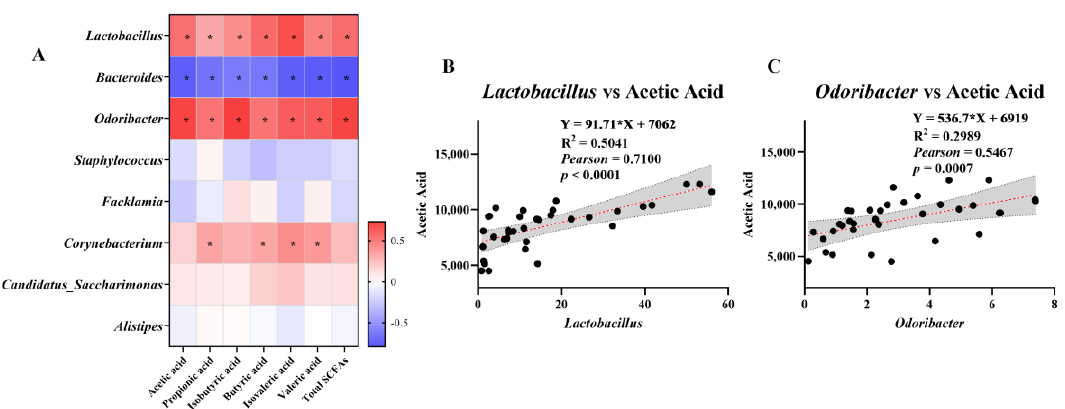
Figure 6. Correlation analysis: ( A ) heatmap of the correlation between fecal SCFAs and microbes, ( B ) positive correlation between Lactobacillus and acetic acid, and ( C ) positive correlation between Odoribacter and acetic acid; * indicates p < 0.05.